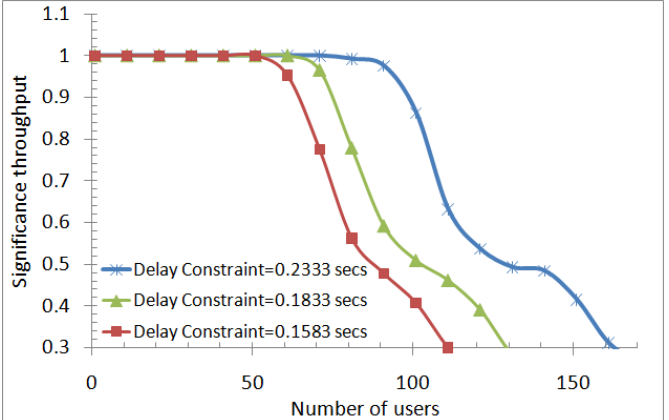
Figure 10. Significance throughput versus number of users for different maximum delay constraints, 100% of users and α =